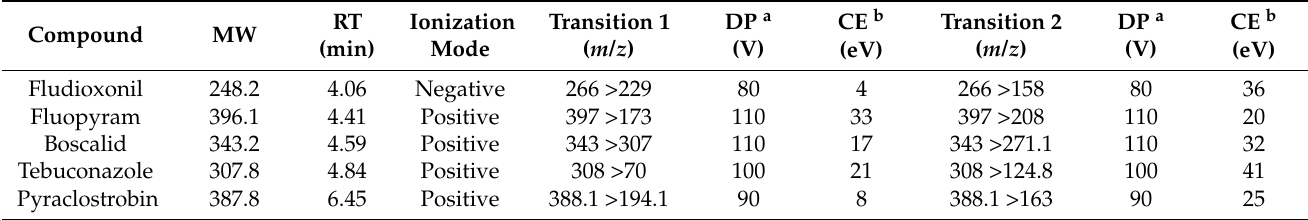
Table 2. Molecular weight (M.W.), retention time (R.T.), ionization mode, MRM transitions, and MS operating parameters optimized for analysis of the selected